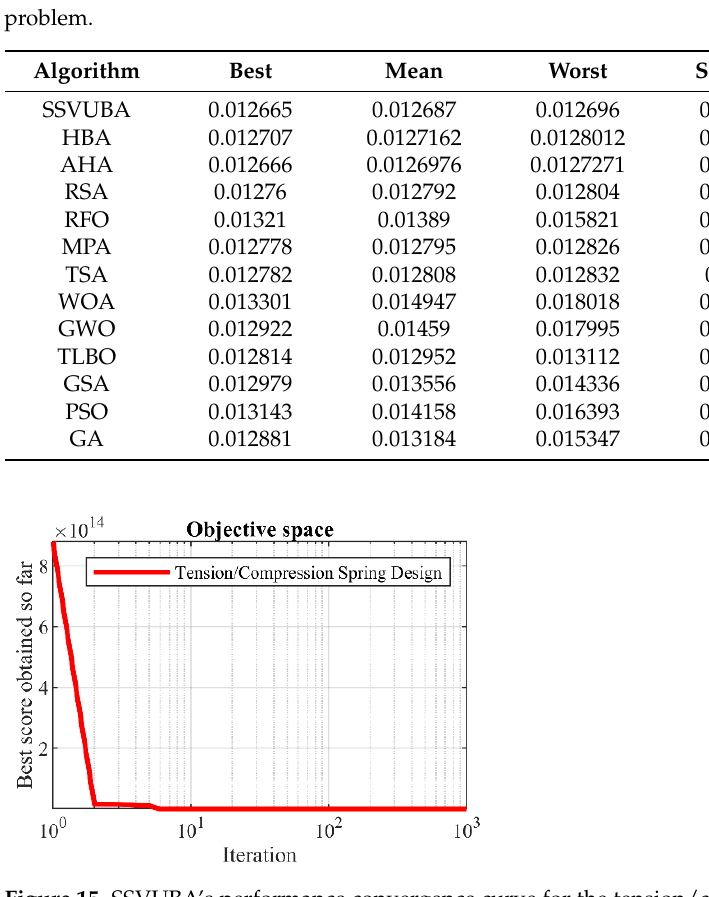
Figure 15. SSVUBA’s performance convergence curve for the tension/compression spring. Table 16. Performance of optimization algorithms for the tension/compression spring design problem.